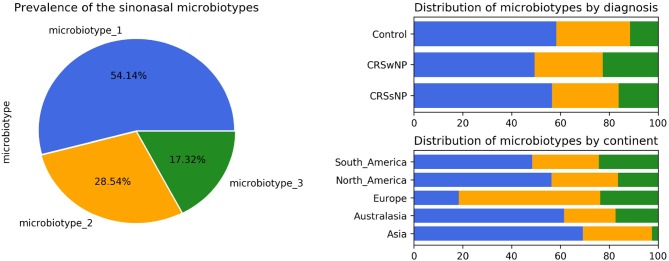
Prevalence and distribution of the microbiotypes.